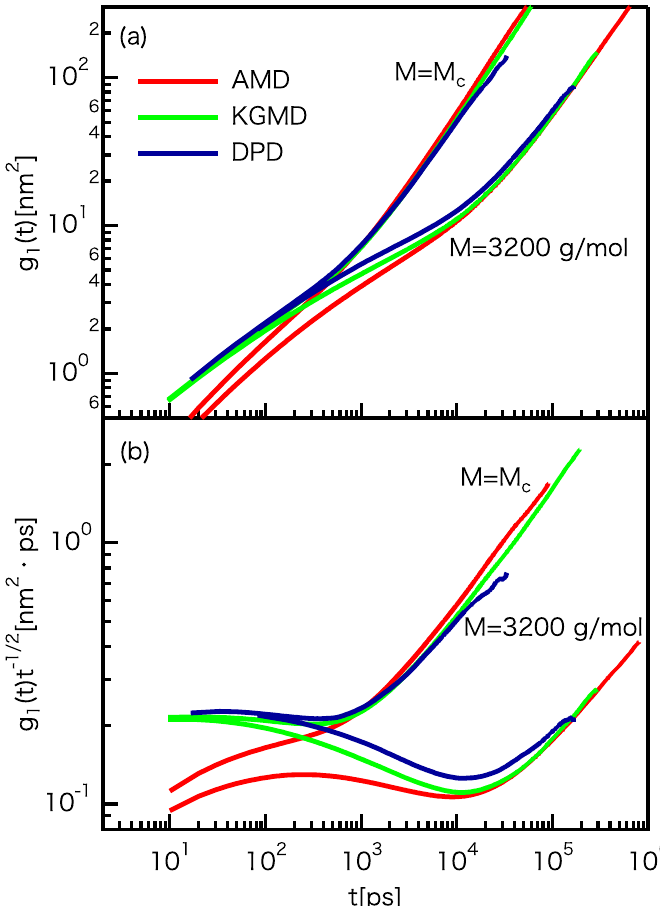
Figure 4. Comparison of the MSD of the chain center g 1 ( t ) for the UA PE model and rescaled